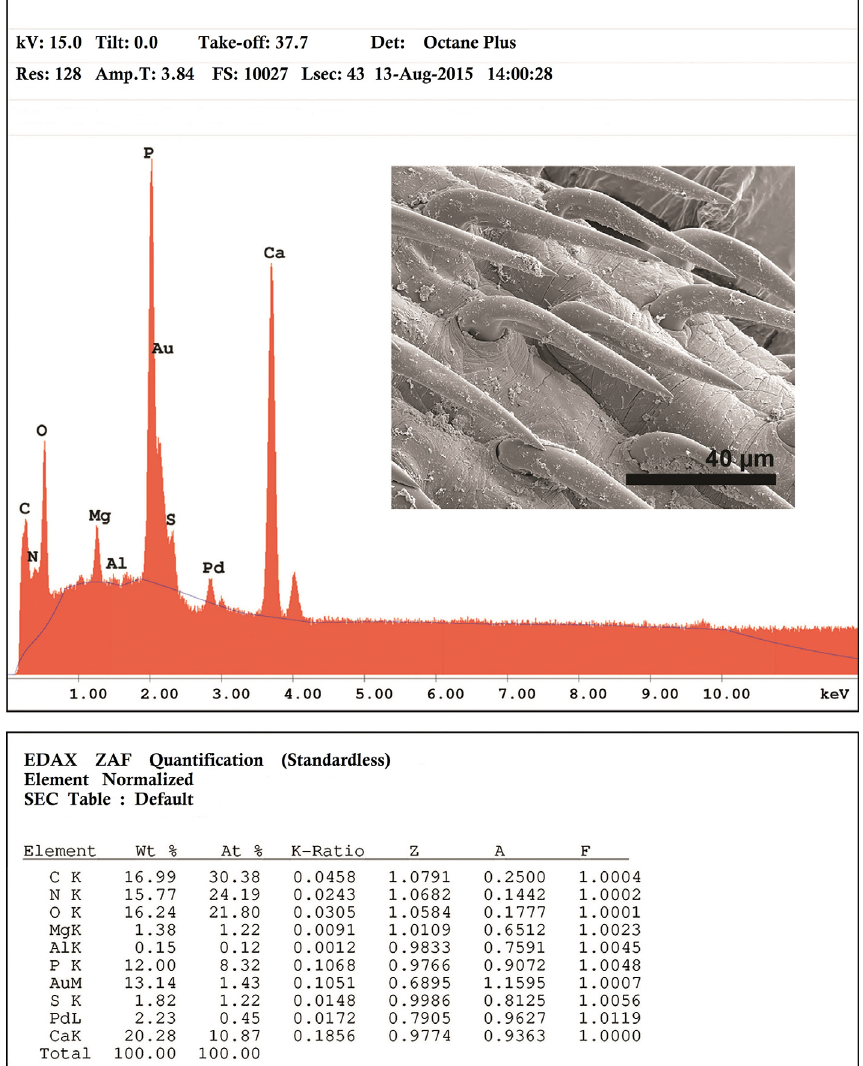
Figure 23. The printout of the elemental scan (EDXA) for the common large hooks for E. baeri . Note height of calcium and phosphorus